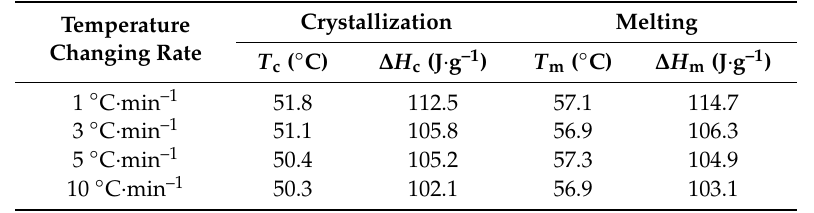
Figure 5. DSC curves of the MC(BeA- co -MMA)3 microcapsule measured at different temperature changing rates (including 1 °C·min –1 , 3 °C·min –1 , 5 °C·min –1 and 10 °C·min –1 ) in the cooling (left) and heating (right) processes. Table 4. Thermal properties of the MC(BeA- co -MMA)3 microcapsule measured at different temperature